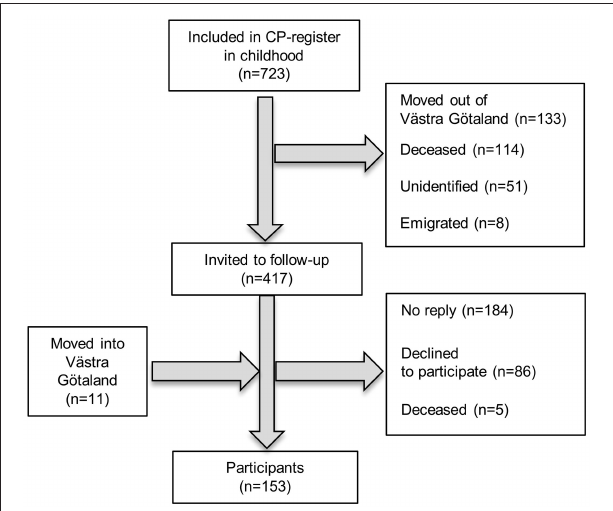
FIGURE 1 | Flow-chart of the inclusion process.